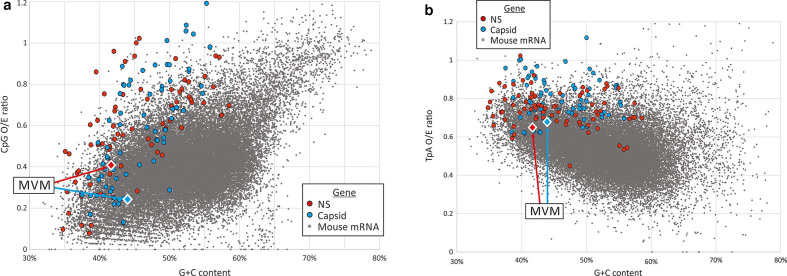
CpG and TpA dinucleotide distribution in parvovirus genes. Comparison of frequencies of CpG and TpA dinucleotides in MVM NS- and capsid-encoding genes (red and blue filled diamonds) and representative other parvoviruses (circles) with those of mouse (Mus musculus) mRNA sequences (each grey point represents a separate gene). Observed (o) CpG and TpA frequencies were normalized to values expected (e) from their G+C content.